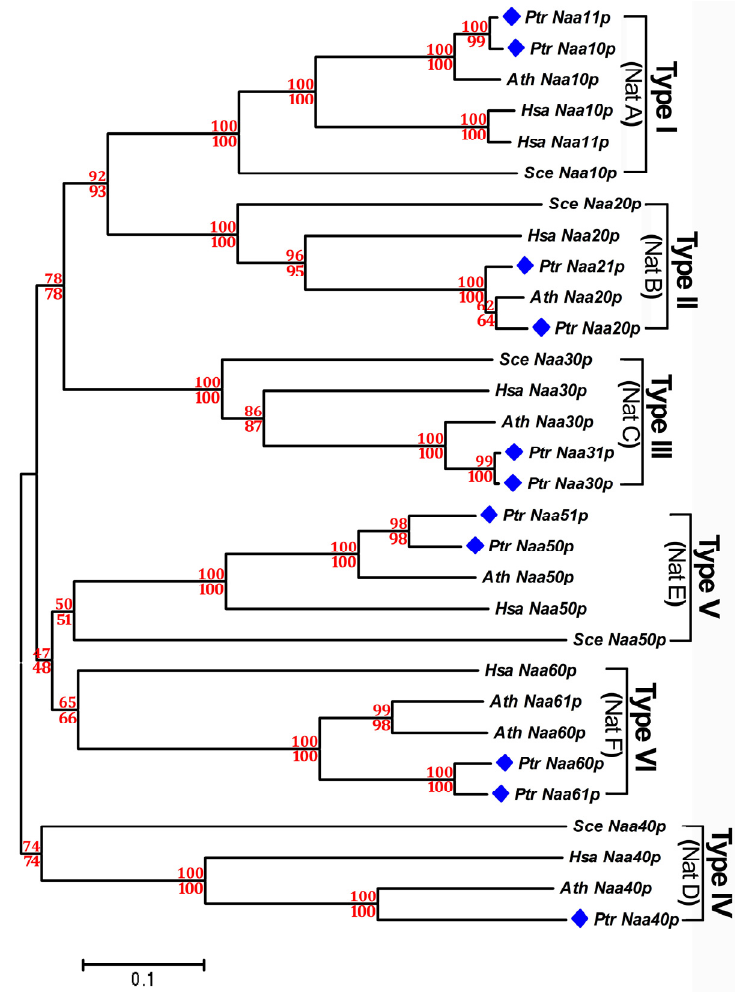
Figure 2. Phylogenetic relationships of poplar Nat CS proteins. Neighbor-Joining bootstrap and Minimum Evolution values for clans supported above the 47% level were respectively indicated above and below the branches in red font. The blue diamonds are highlighted in the front of all Nat CS subtypes from Populus . All poplar Nat CS and AS protein names and their individual corresponding ID number for phylogenetic analysis are listed as in Table 1. Sce Naa10p (P07347); Sce Naa20p (Q06504); Sce Naa30p